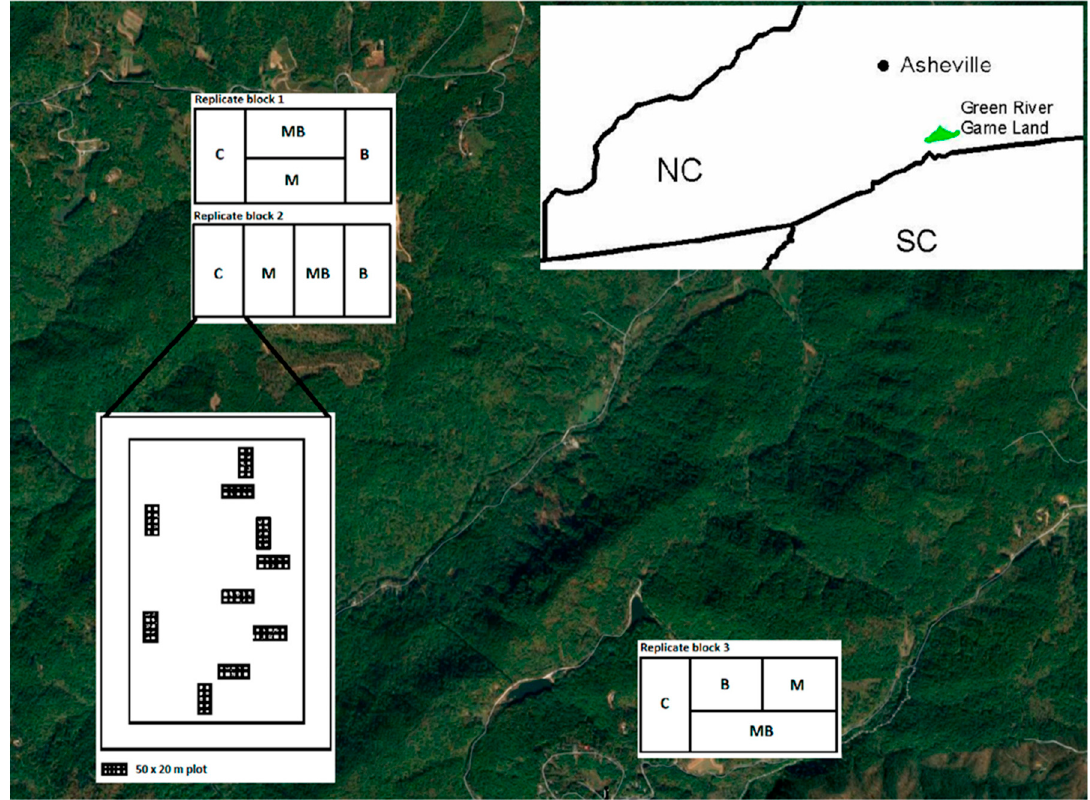
Figure 1. Location of replications 1, 2, and 3 utilized for this research study located on the Green River Game Lands near Asheville, NC, USA [14].